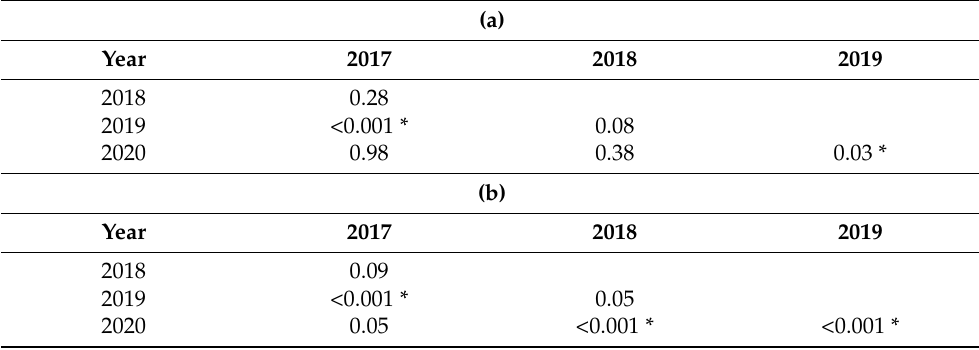
Table 2. ( a ) Pairwise Wilcoxon Signed Rank result of national report completeness mean rate com- pared between years. ( b ) Pairwise Wilcoxon Signed Rank test result of national report timeliness rate compared between